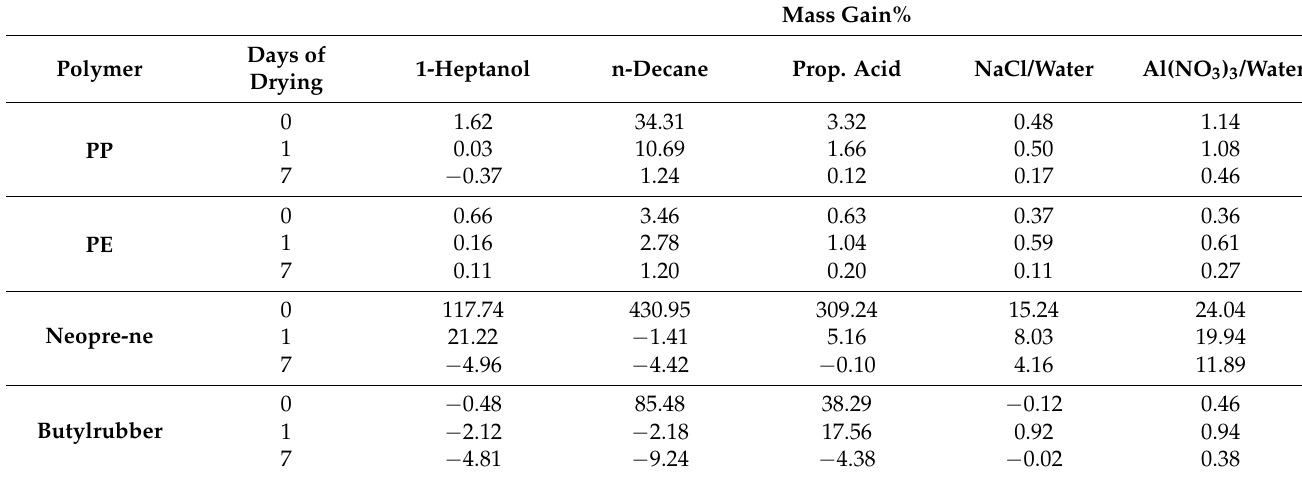
Table 6. Mass gain of polypropylene (PP), polyethylene (PE), neoprene and butyl rubber samples after 7 days of immersion in the five different PCMs and after drying in laboratory conditions for 0, 1, and 7